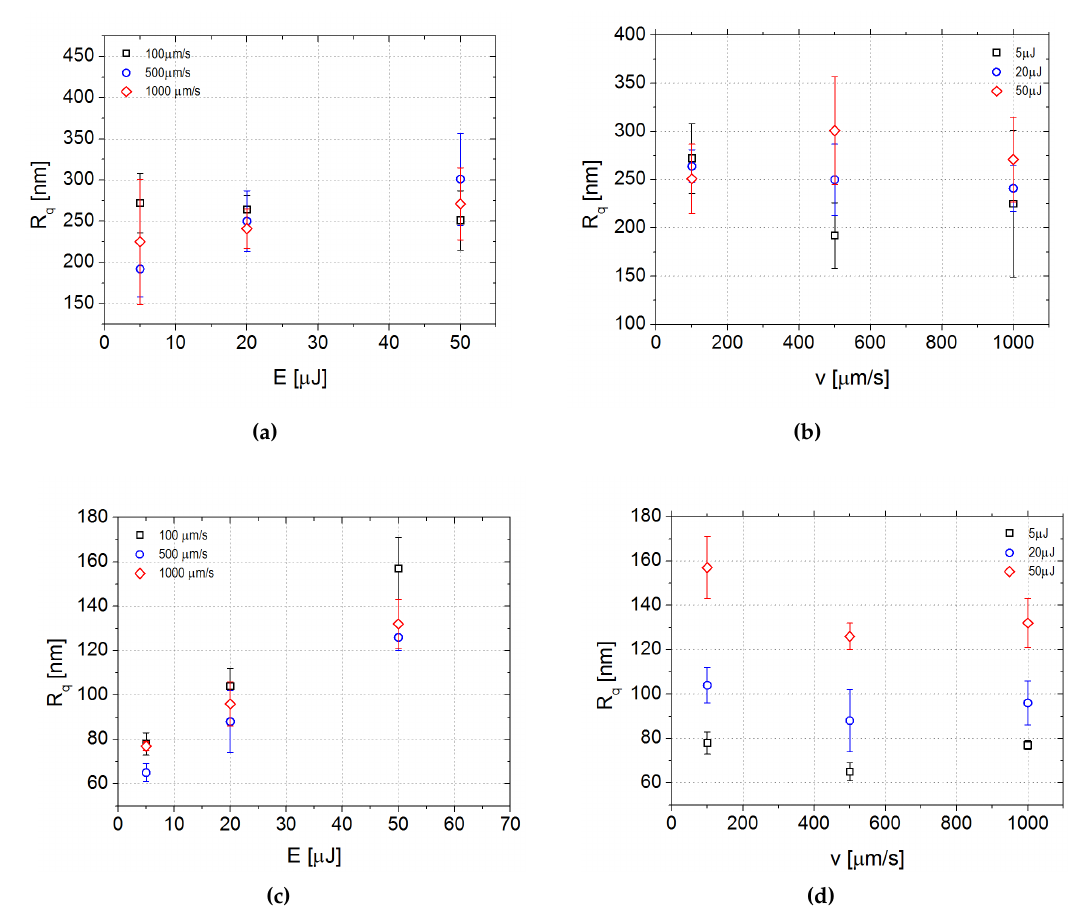
Figure 7. Dependence of the roughness of the channels on the process parameters for the laser ablated samples: ( a , b ) R q of the bottom surface of the channels as a function of the pulse energy and the scanning speed, respectively; ( c , d ) R q of the lateral surface of the channels as a function of the pulse energy and the scanning speed, respectively.